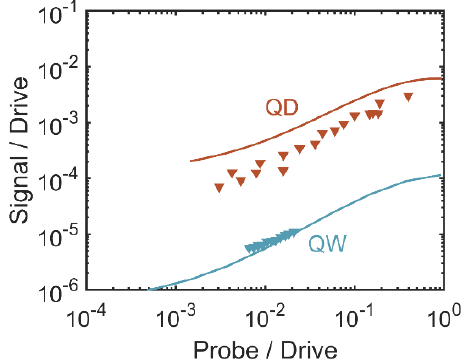
Figure 5. Four-wave mixing efficiency with the frequency detuning in the Stokes condition Δ𝜐 (cid:3406) −300 GHz for the QD (burgundy) and for the QW (jade) laser. The calculated values are a solid line, and the experimental measurements are given by triangles.